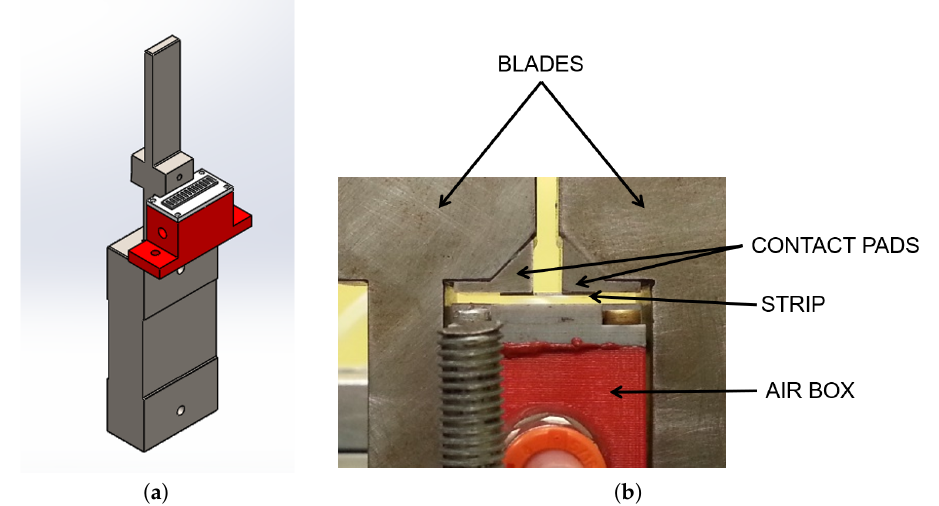
Figure 2. ( a ) scheme of the blades with the compressed air loading system; ( b ) close up on the strip loaded by the compressed